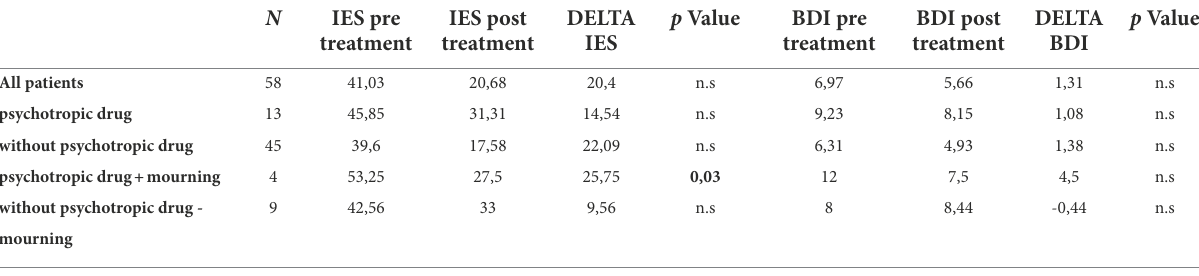
TABLE 2 Averages values of IES-R and BDI scores of patients agreed psychological treatment and stratified for use or not of psychotropic drug and presence or not of family mourning.